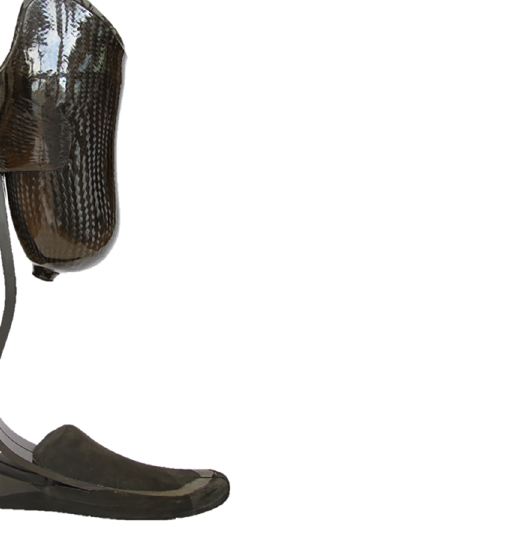
Fig 1. Prostheses with an ESF (left) and an XF